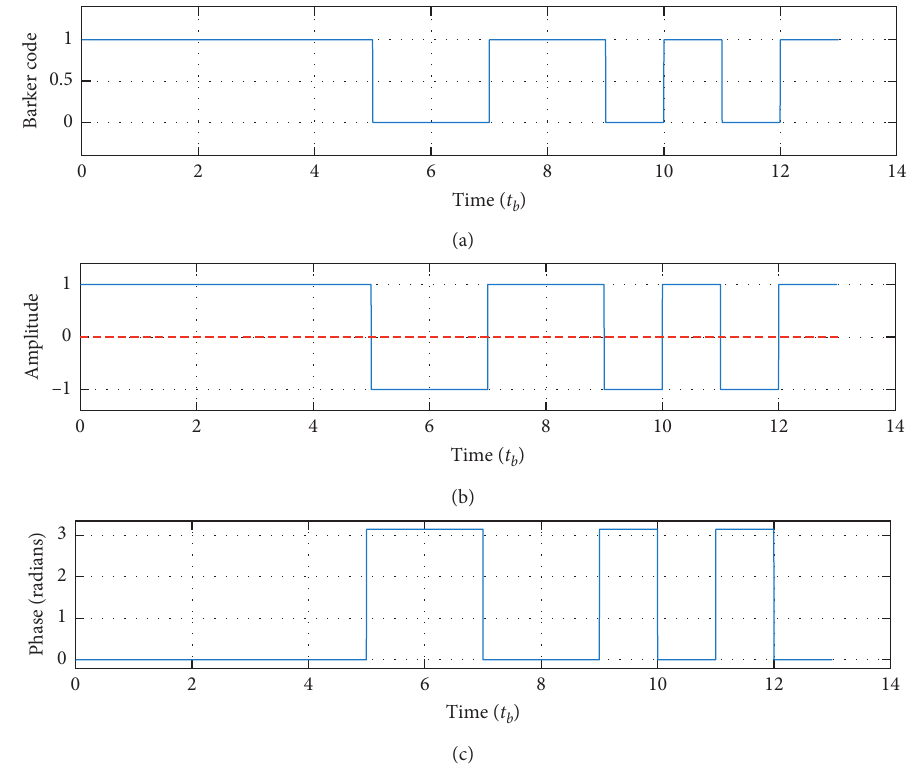
Figure 18: One pulse of Barker code: (a) 13-chip Barker code, (b) the Barker code I / Q waveform (solid and dashed lines are I and Q , respectively), and (c) phase in each chip of I / Q signal.